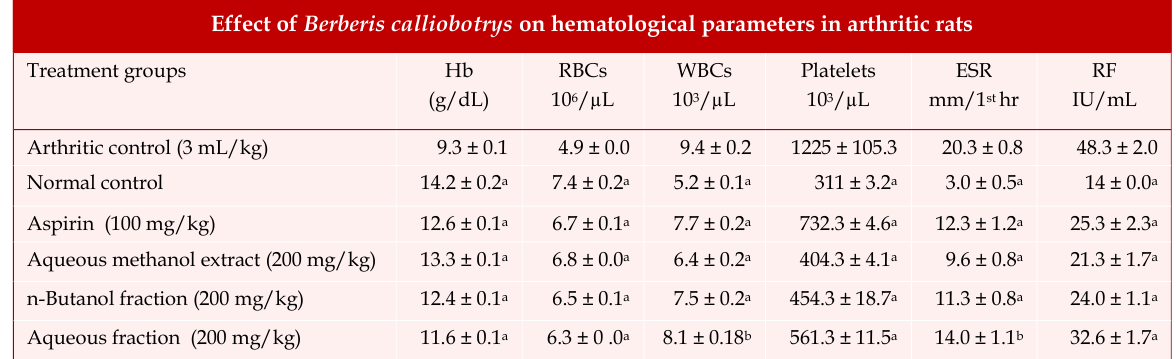
Effect of Berberis calliobotrys on hematological parameters in arthritic rats